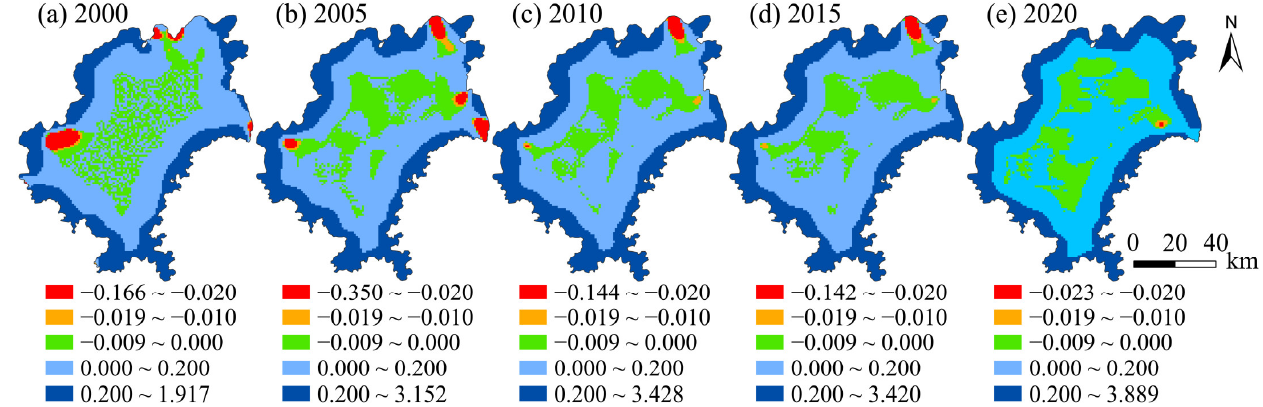
Figure 7. Spatial distribution map of regression coefficients of human footprint index in Guiyang from 2000 to 2020.